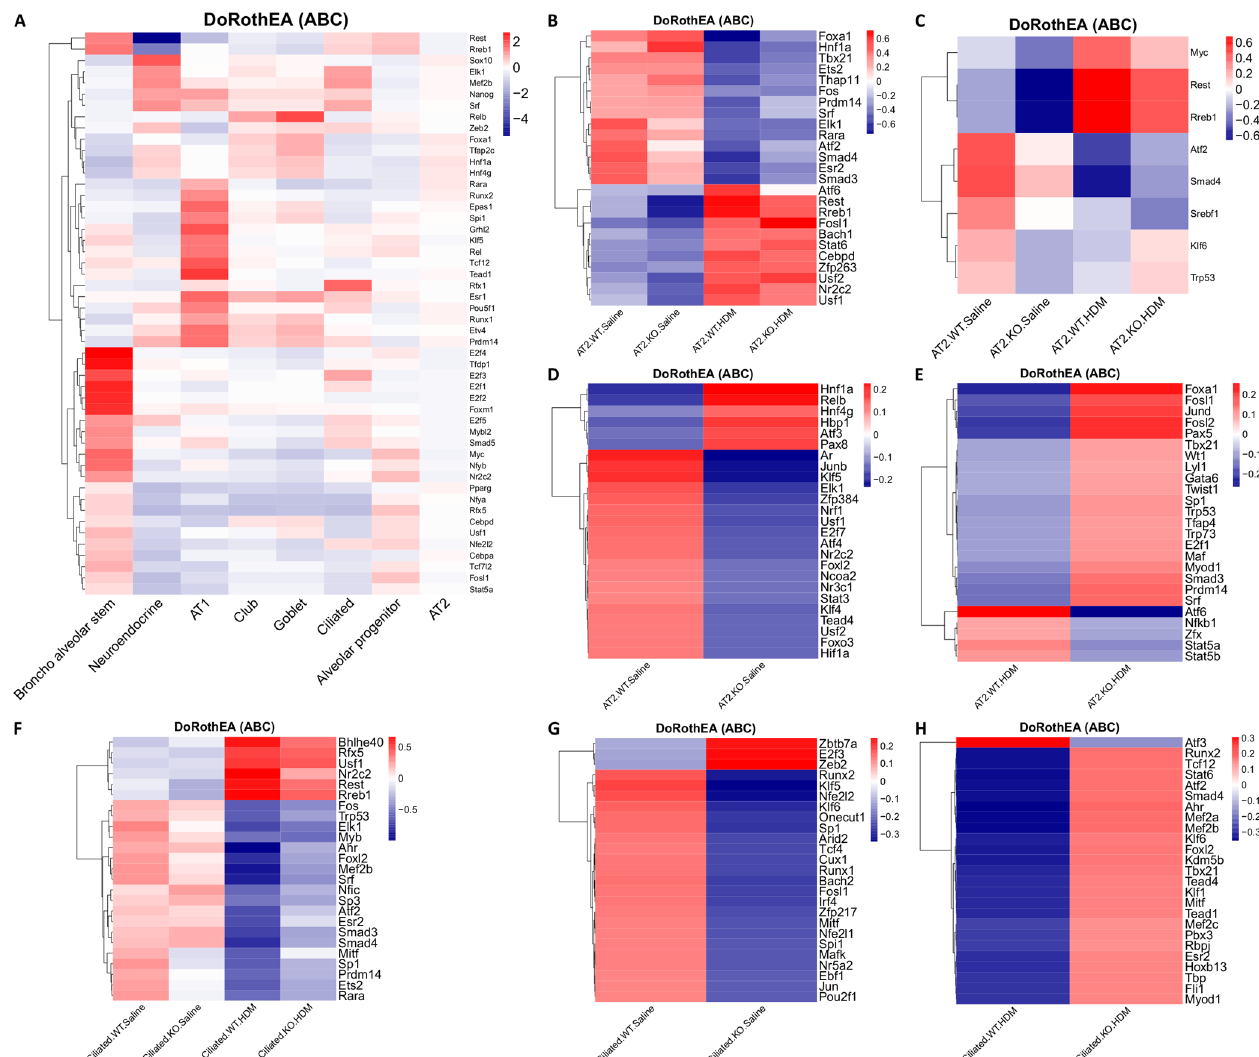
Figure 6. Heatmaps of transcription factor (TFs) activities analyzed using DoRothEA. ( A ) Top 50 most variable TFs by gene activity across 8 individual cell types. ( B ) Top 25 TFs across all AT2 cells. ( C ) TFs that were in the top 25 in both the KO-HDM vs. WT-HDM and KO-Saline vs. WT-Saline comparisons in AT2 cells. ( D ) Top 25 TFs in the KO-Saline vs. WT-Saline comparison that were not in the top 25 for KO-HDM vs. WT-HDM in AT2 cells. ( E ) Top 25 TFs in the KO-HDM vs. WT-HDM comparison that were not in the top 25 for KO-Saline vs. WT-Saline in AT2 cells. ( F ) Top 25 most- variable TFs in ciliated cells. ( G ) Top 25 most-variable TFs in ciliated cells in KO-Saline vs. WT-Saline. ( H ) Top 25 most-variable TFs in ciliated cells in KO-HDM vs. WT-HDM.